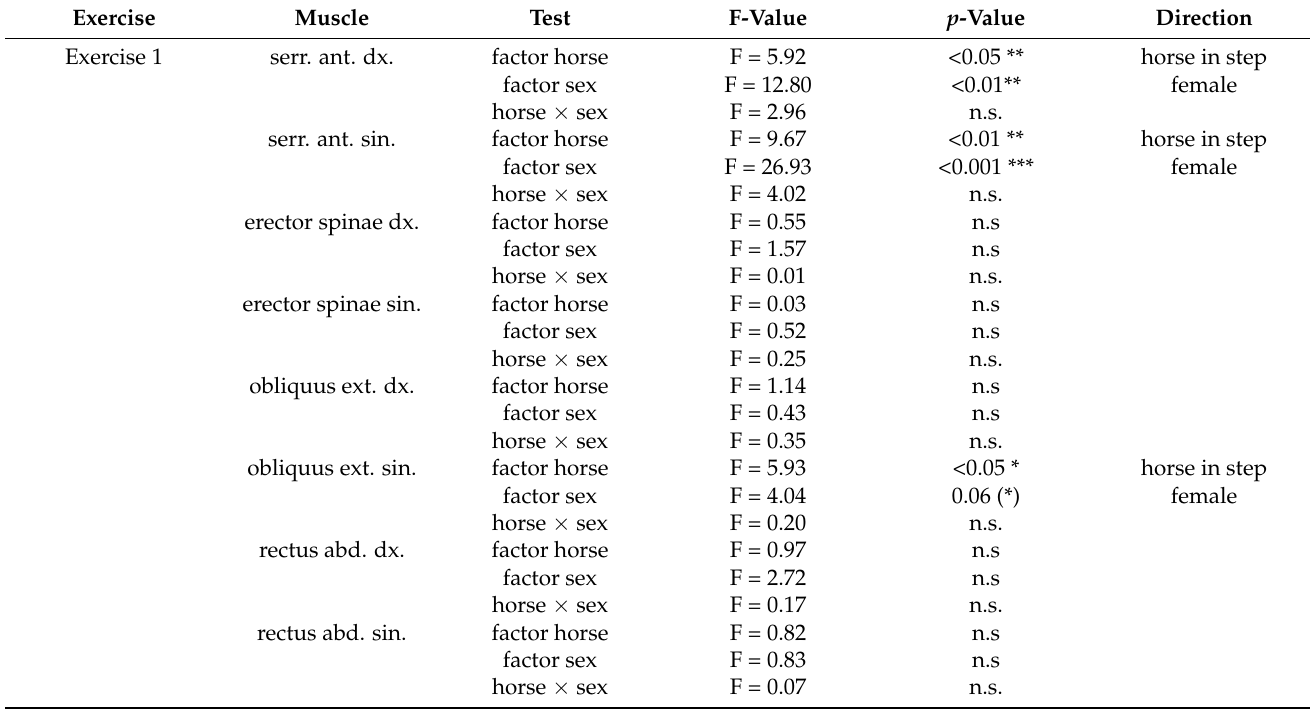
Table 1. Summary of two-way ANOVAs testing the effect of factors treatment (horse: gymnastic vs. in step) and sex (male, female) on muscle activity (expressed as the % MVC across three replicated measurements). Statistically significant results are shown: * p < 0.05 ** p < 0.01, *** p < 0.001, including marginally significant (0.05 > p < 0.1), marked (*); n.s. = non-significant, df = 1, 14; horse × sex = interaction of both factors. For each significant test, the column Direction shows for which factor the higher value was